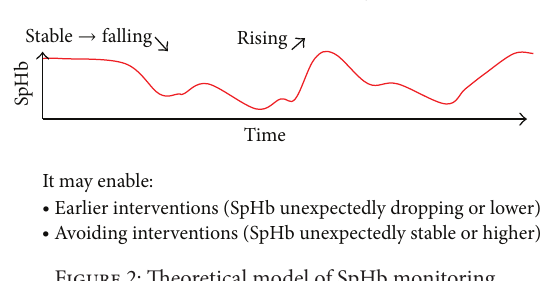
Figure 2: Theoretical model of SpHb monitoring.